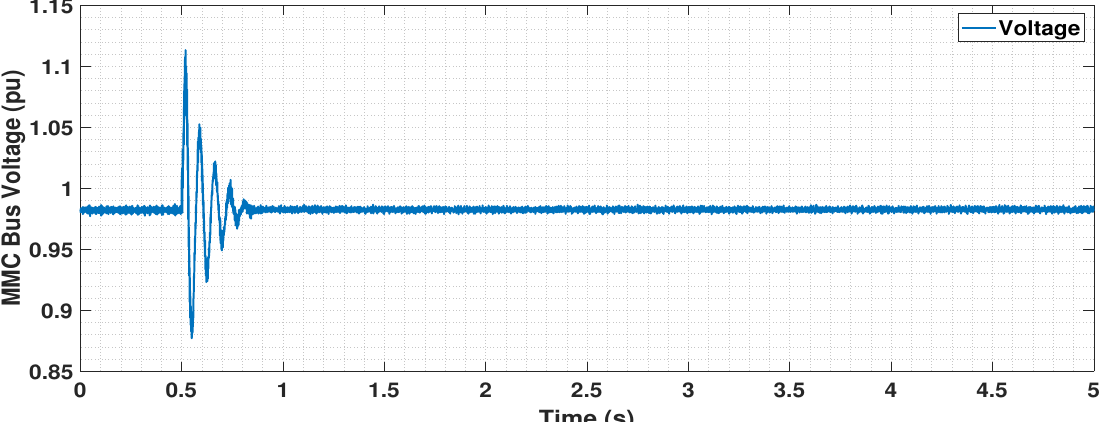
Figure 15. Voltage in p.u. at MMC bus upon CB-6a closing